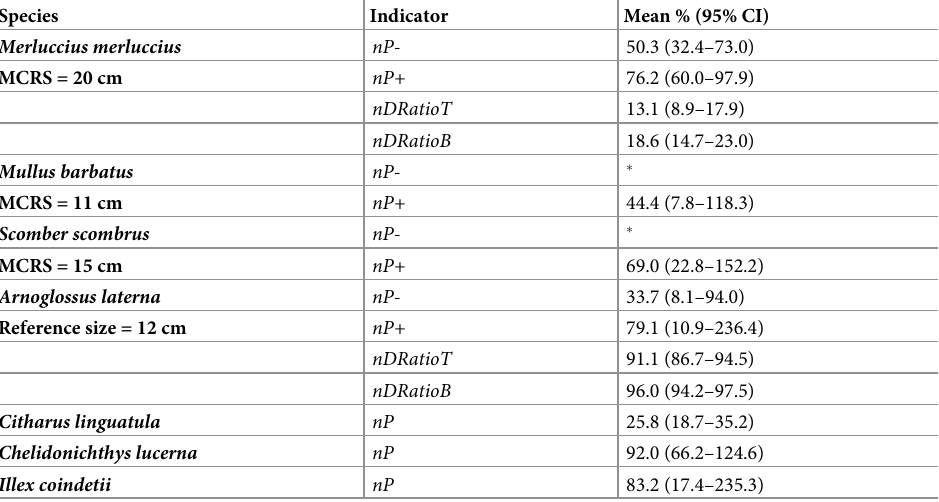
Table 5. Values of the exploitation pattern indicators (in average percentages with 95% confidence intervals) for the species selected for the catch comparison analysis. They represent the number of individuals i.e. nP (total), nP- (below the reference size), nP+ (above the reference size) retained by the test codend (DM50) compared to the baseline codend (SM40), and the resulting discard ratios estimated for both the test (nDRatioT) and baseline (nDRatioB)